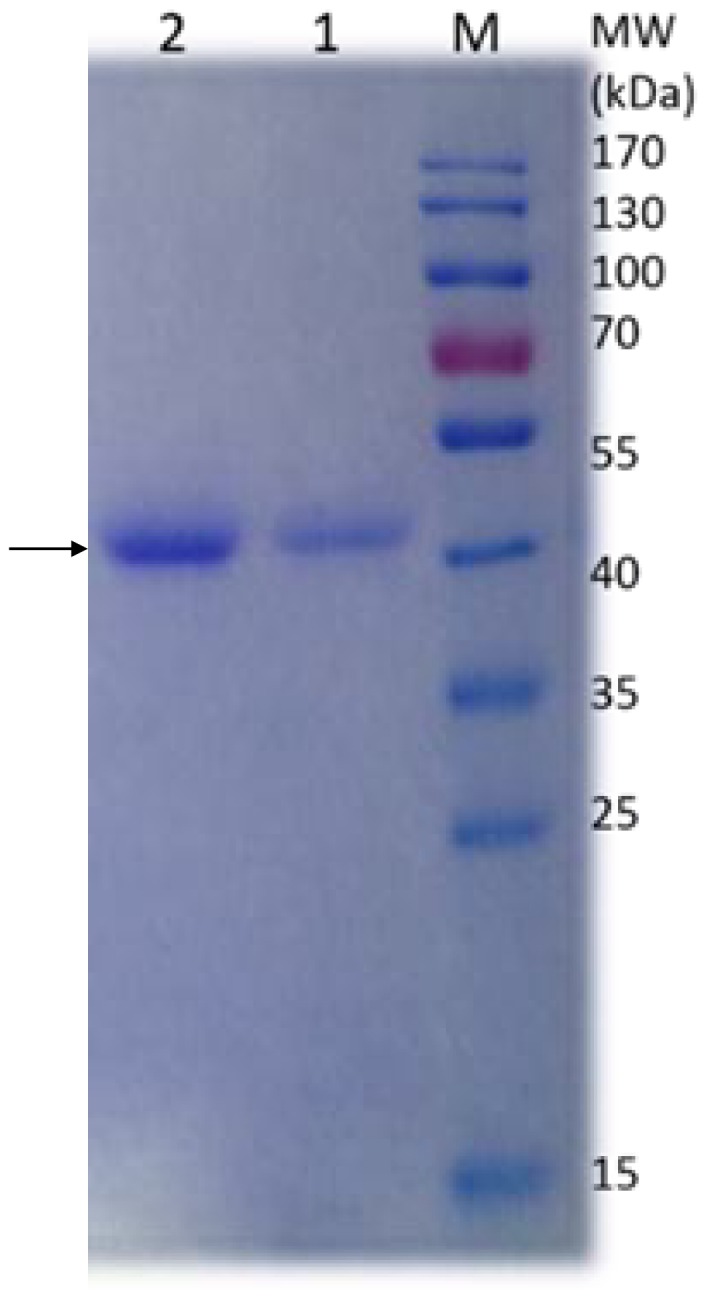
SDS-PAGE analysis of the purified MnP from Irpex lacteus CD2.lane M: molecular mass marker; lane 1 and lane 2: purified MnP.